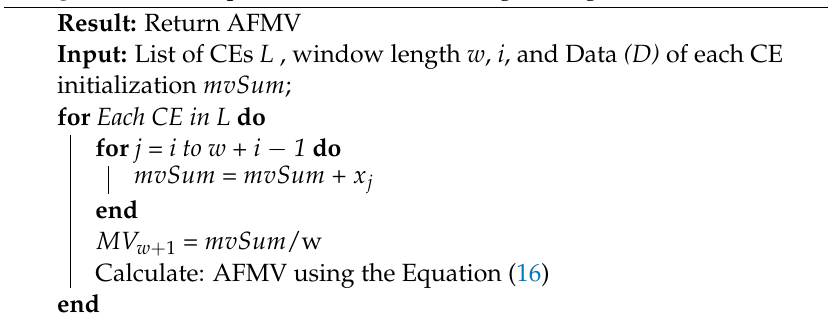
Algorithm 3: Adaptive Filter-based Moving Average